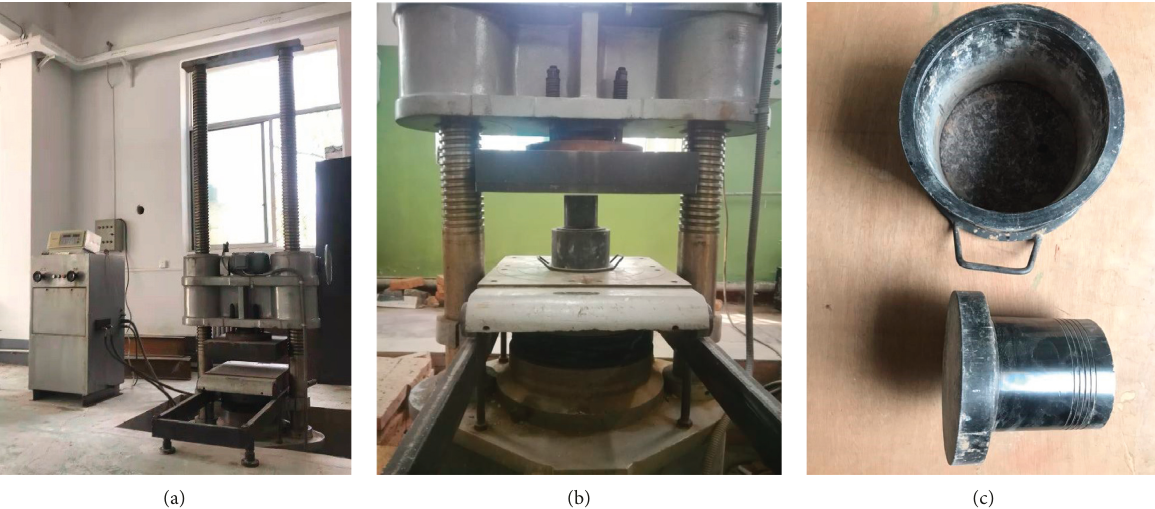
Figure 1: Laterally confined crushing test equipment. (a) YE-2000A hydraulic press. (b) Laterally confined crushing test. (c) Sample barrel and